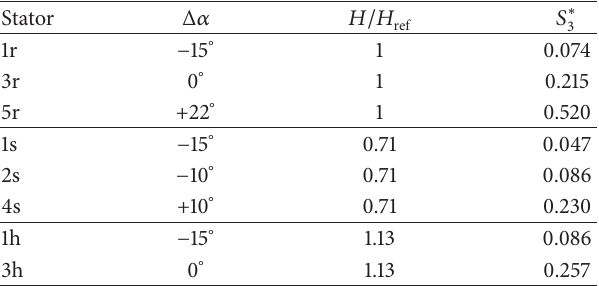
Table 1: Characteristics of the stators. Table 2: Repeatability uncertainty of the